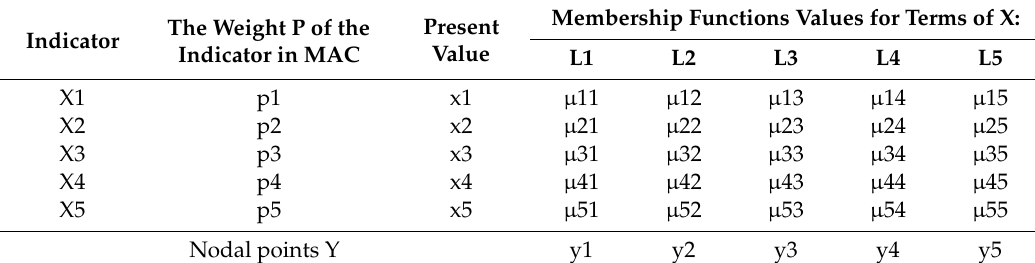
Table 1. An example of the MAC for the assessment of RI (for N = 5 and M = 5). The Weight P of the Indicator Indicator in MAC